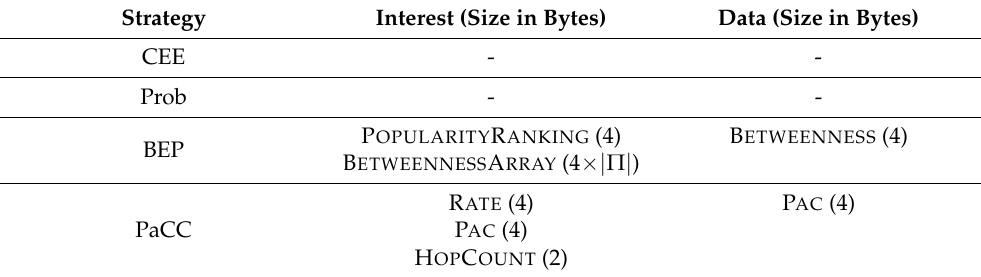
Table 4. Additional fields per packet: PaCC vs. benchmark